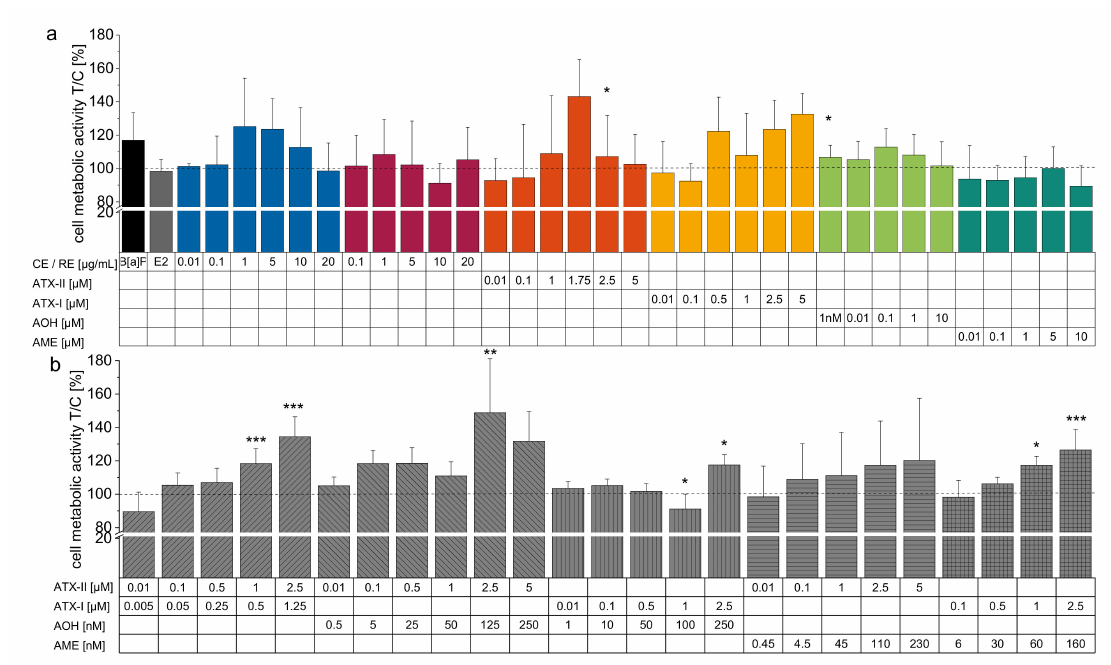
Figure 5. CellTiter-Blue ® assay. Metabolic activity measurements after 24 h of incubation presented as means + SD in comparison to solvent control (1 % DMSO) of at least 3 individual